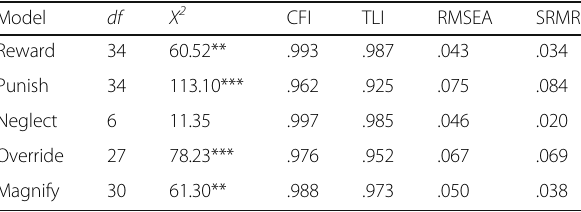
Table 2 Fit Indices for the five models of emotion socialization